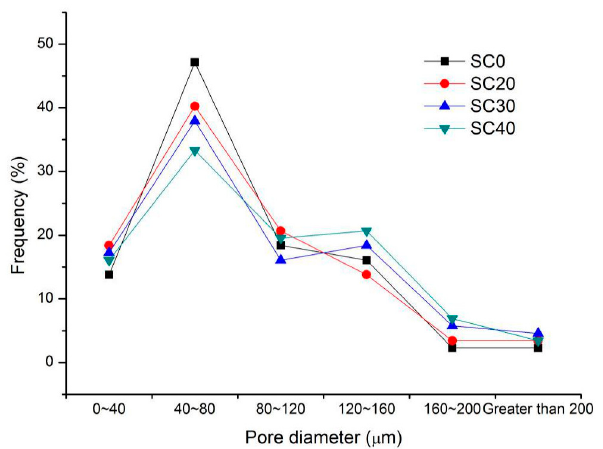
Figure 9. Pore size distribution of the air-void structure of series II mixtures.